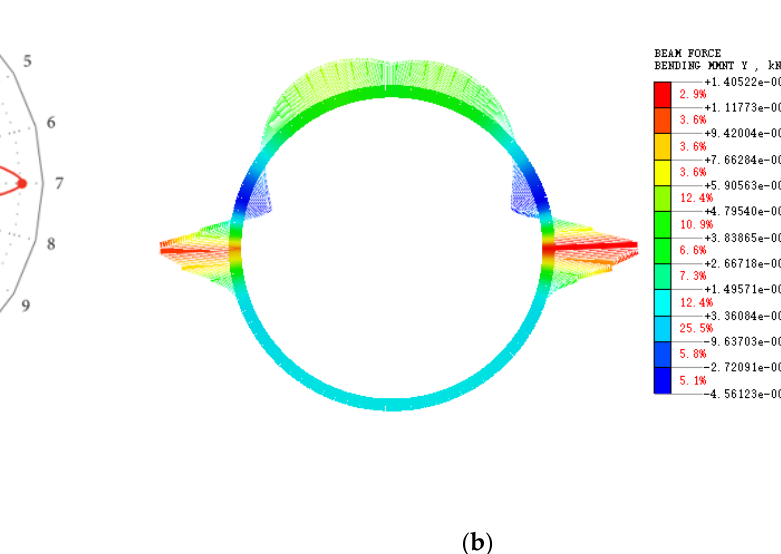
Figure 6. Comparison of bending moment diagram between numerical simulation results and shaking table test results: ( a ) Shaking table test; ( b ) Finite element model.